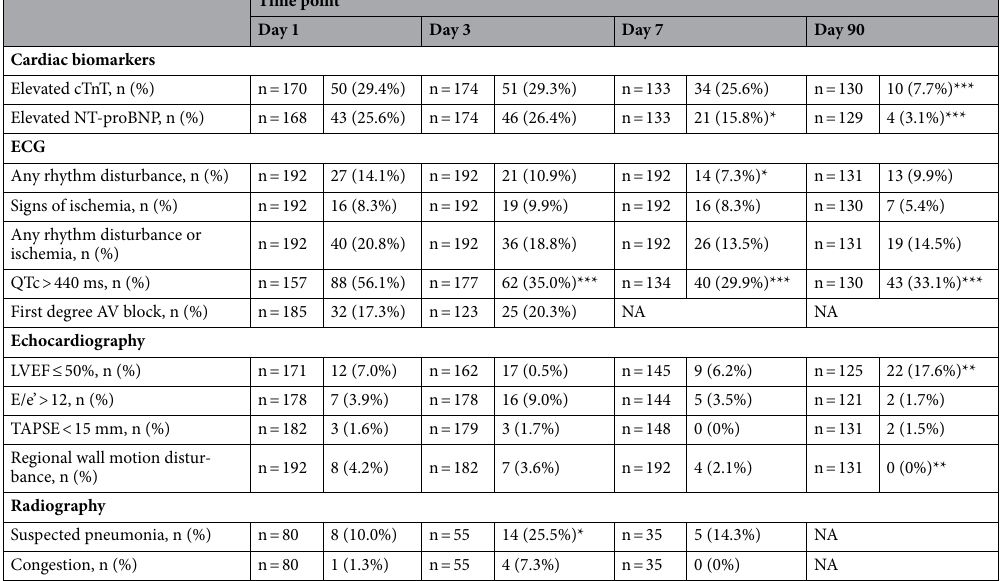
(Supplement Table S2). The proportion of patients with elevated cTnT was significantly lower at day 90 (7.7%) compared to day 1 (29.4%; p < 0.001). The proportion of patients with elevated NT-proBNP was significantly lower at day 7 (15.8%) and day 90 (3.1%) compared to day 1 (25.6%; p < 0.001). The most common ECG finding was QTc prolongation, with an incidence of 56.1% at day 1, 35.0% at day 3, 29.9% at day 7 and 33.1% at day 90 (all p < 0.001 compared to day 1). At day 90, there was a higher proportion of patients with reduced LVEF (< 50%) and a lower proportion of patients with regional wall motion abnormalities compared to the baseline. Concentrations of cTnT at day 1 according to different categories of clinical status, severity of bleeding and categories of cardiopulmonary events and outcome measures are presented in Table 5. Patients with a worse clinical status and more severe bleeding exhibited higher concentrations of cTnT, which was also the case for patients with worse neurological outcomes at the three-month follow-up. The corresponding analyses for NT-proBNP and endogenous catecholamines are presented in Tables 6 and 7. Concentrations of NT-proBNP were associated with the Glasgow Coma Scale, QTc prolongation and regional wall disturbances on the echocardiography. Concentrations of endogenous catecholamines were similar across all analyzed subgroups, apart from different concentrations of endogenous epinephrine according to the Fisher grad- ing score (lower in more severe grades) and different concentrations of endogenous norepinephrine according to Hunt and Hess and the World Federation of Neurological Surgeons grading score (higher in more severe grades).